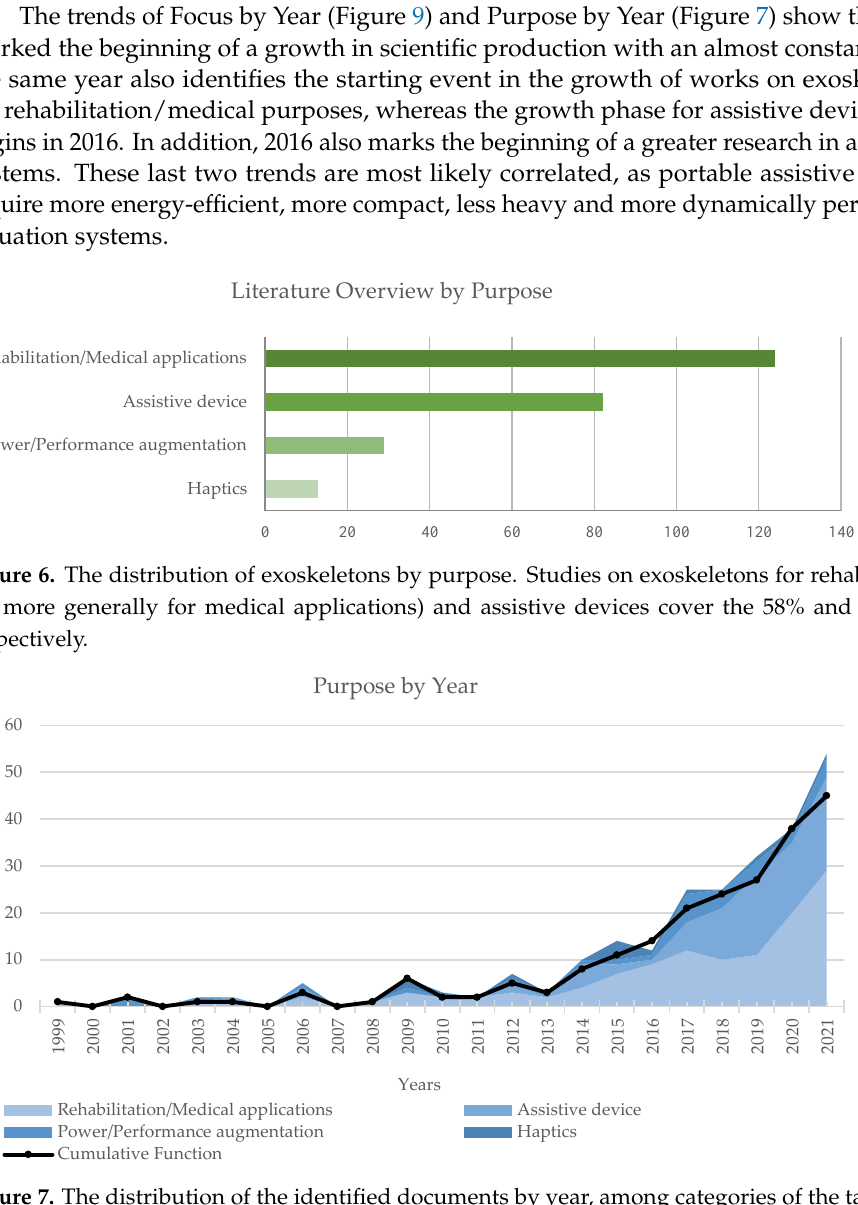
Figure 7. The distribution of the identified documents by year, among categories of the taxonomy by purpose. The data include all the occurrences and are presented in stacked format. In the black line with dots is the total amount of documents by year. A growth trend in the scientific production of articles for medical applications occurs since 2013, and, around 2019, the growth rate of related papers increases.